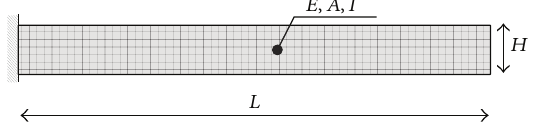
Figure 1: Cantilever beam